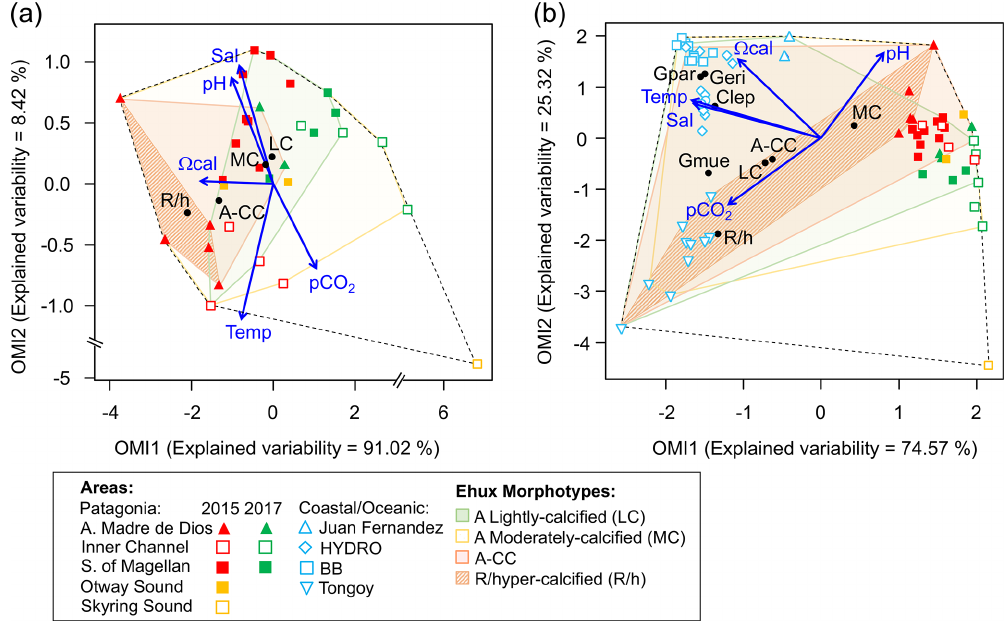
Figure 9. Outlying mean index (OMI) niche analysis by E. huxleyi ( Ehux ) morphotypes populating the surface waters of southern Patagonia and complemented with coccolithophores and Ehux morphotypes from nearby coastal and oceanic waters constrained by environmental conditions. (a) Biplot representing the realized niche of four E. huxleyi morphotypes during late austral spring 2015 and early spring 2017 in Patagonia, where black circles indicate the mean habitat condition used by each morphotype (niche position) and polygons delimit their respective niche breadth (i.e., tolerance). Blue vectors represent the gradients of environmental variables. (b) Realized niches of Ehux mor- photypes and other coccolithophore species in Patagonia fjords (this study) and nearby coastal/oceanic waters (data from von Dassow et al., 2018). Polygons of other coccolithophore species in (b) are not shown for simplicity. Temp: temperature; Sal: salinity; LC: E. huxleyi lightly calcified A morphotype; MC: E. huxleyi moderately calcified A morphotype; A-CC: E. huxleyi A-CC morphotype; R/h: E. huxleyi R/hyper-calcified morphotype; Gpar: Gephyrocapsa parvula ; Geri: Gephyrocapsa ericsonii ; Gmue: Gephyrocapsa muellerae ; Clep: Cal- cidiscus leptoporus